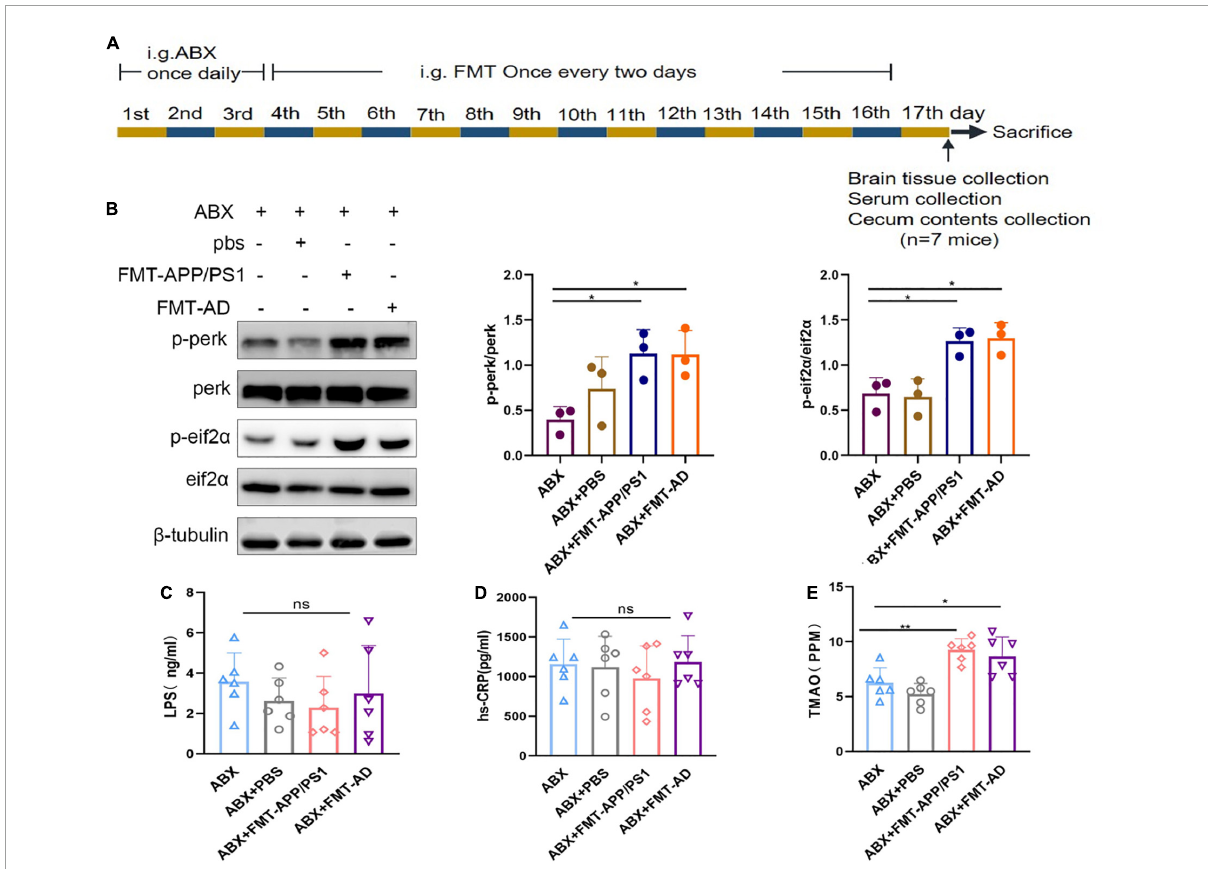
FIGURE2 Cortical endoplasmic reticulum (ER) stress marker protein and serum hs-CRP, LPS, and TMAO levels in wild-type (WT) mice after fecal microbiota transplantation (FMT). (A) Experimental design of FMT-treated mice. (B) Representative immunoblots showing p-perk and p-eif2a levels in the cerebral cortex on day 17 of the experiment. (C) Serum hs-CRP levels after FMT. (D) Serum LPS levels after FMT. (E) Serum TMAO levels after FMT. P < 0.05 was set as the threshold for significance by one-way ANOVA followed by post-hoc comparisons using LSD’s test for multiple groups’ comparisons, * p < 0.05 and ** p <